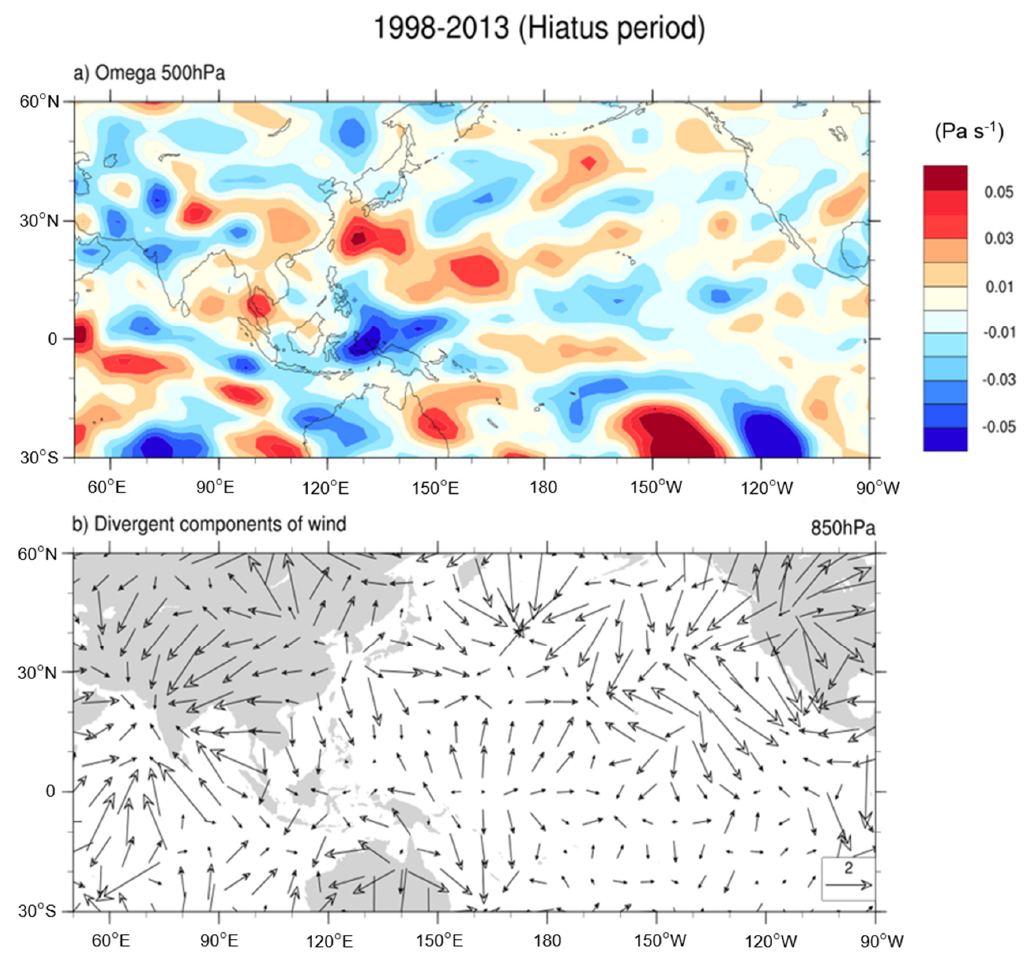
Figure 16. Composite anomalies of omega at 500 hPa ( a ) and divergent components of the wind at 850 hPa ( b ) between positive and negative years of EOF2 during the hiatus period.